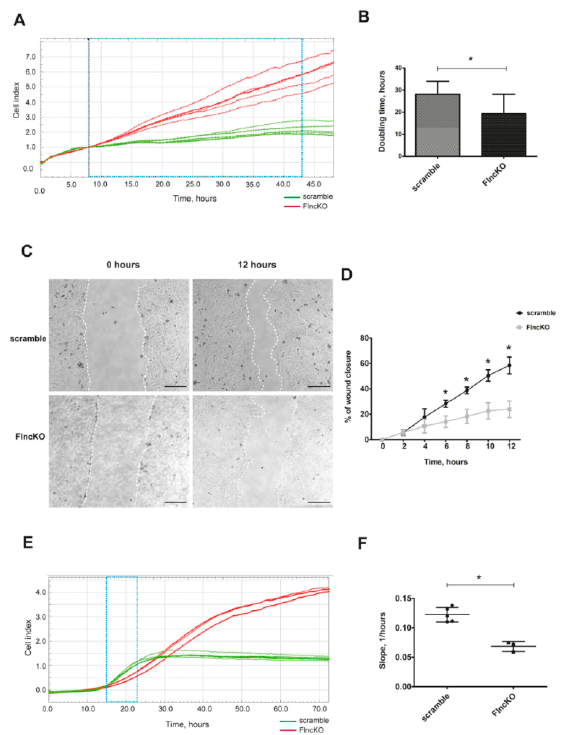
Figure 1. Reinforced proliferation and impairment of migration ability of FlncKO line. ( A ) Proliferation dynamics was obtained by xCELLigence Real-Time Cell Analyzer (RTCA), normalized cell index (CI) curves are presented. ( B ) Quantification of doubling time in 15 to 43 hours’ time range revealed an increase of proliferation rate in FlncKO cell line ( n = 15 for each cell line). ( C ) Scratch assay shows a decrease of migration capacity from FlncKO cell line compared to scramble control; cell migration was recorded from 2 to 12 h. Representative images are shown for 12 hours’ time point. Dashed lines indicate area for quantification. ( D ) Reduction in cell migration was significant from 6 hours’ time point until 12 hours’ time point ( n = 4 for each cell line and time points). ( E ) Validation of migration results performed by RTCA analysis. Migration curves represent cell index in each time point. ( F ). Quantification analysis of migration curves slopes was performed between 15 to 23 h after cell seeding. Scale bar 200 µ M. For all * p <